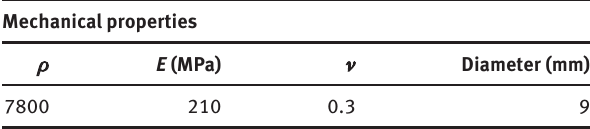
Figure 9 Projectile used in the gas gun. Table 1 Geometry and characteristics of the projectile.